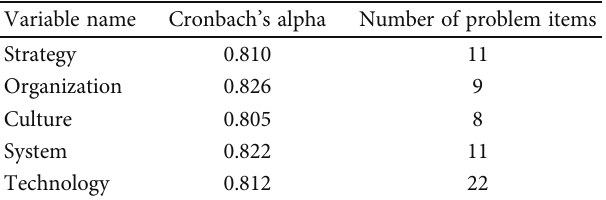
Table 7: Reliability analysis of measurement scale.